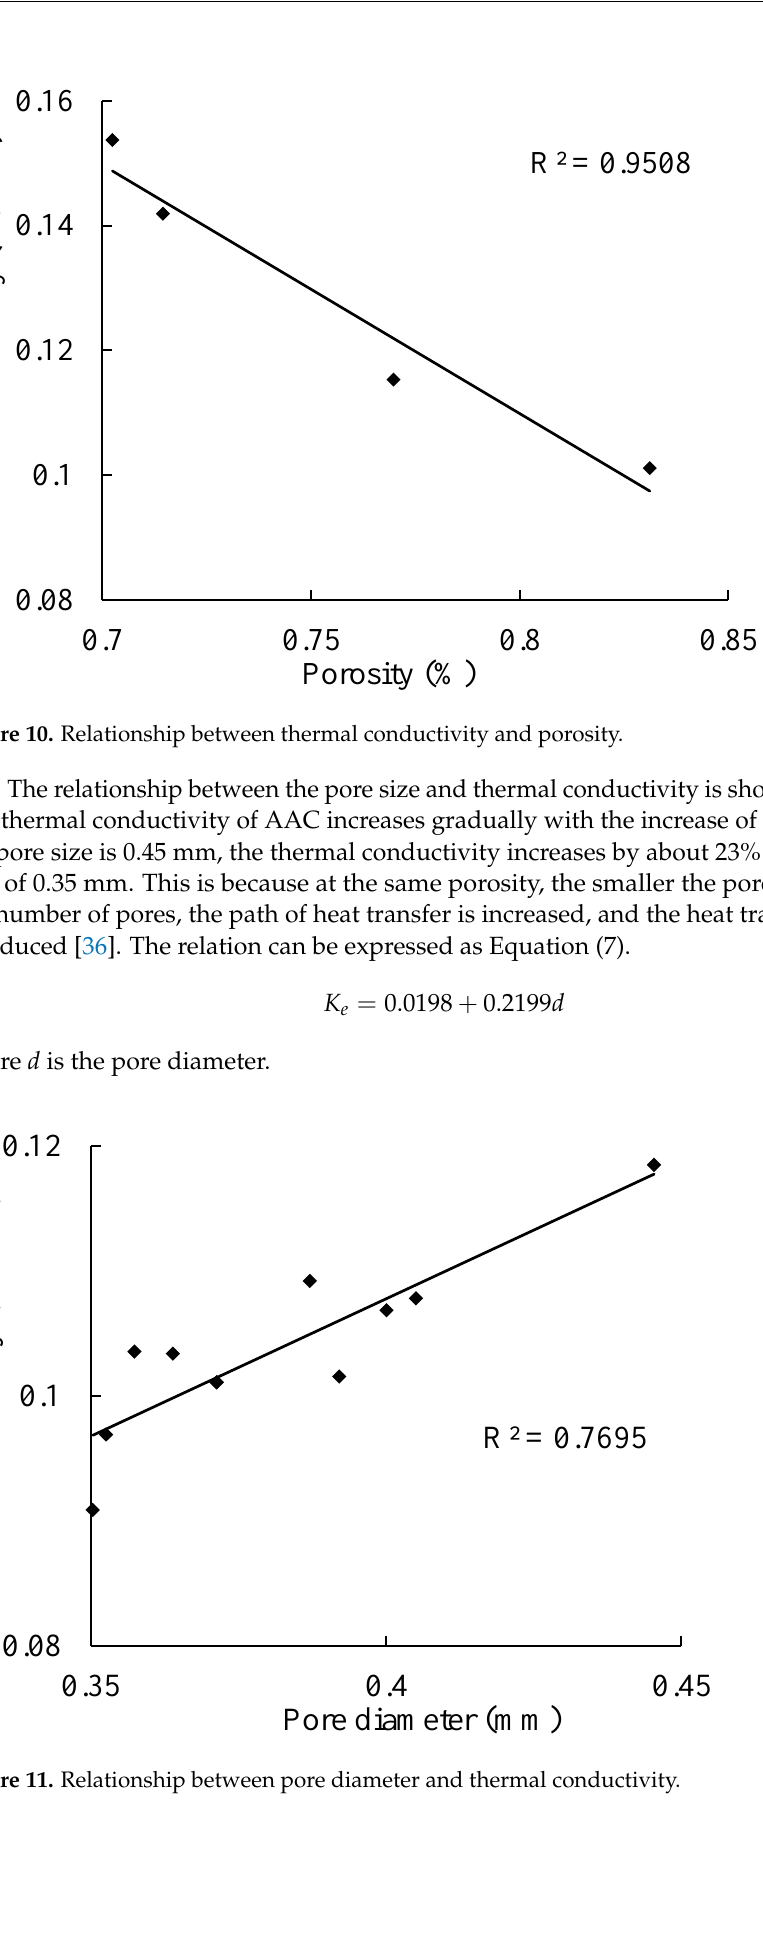
Figure 11. Relationship between pore diameter and thermal conductivity.